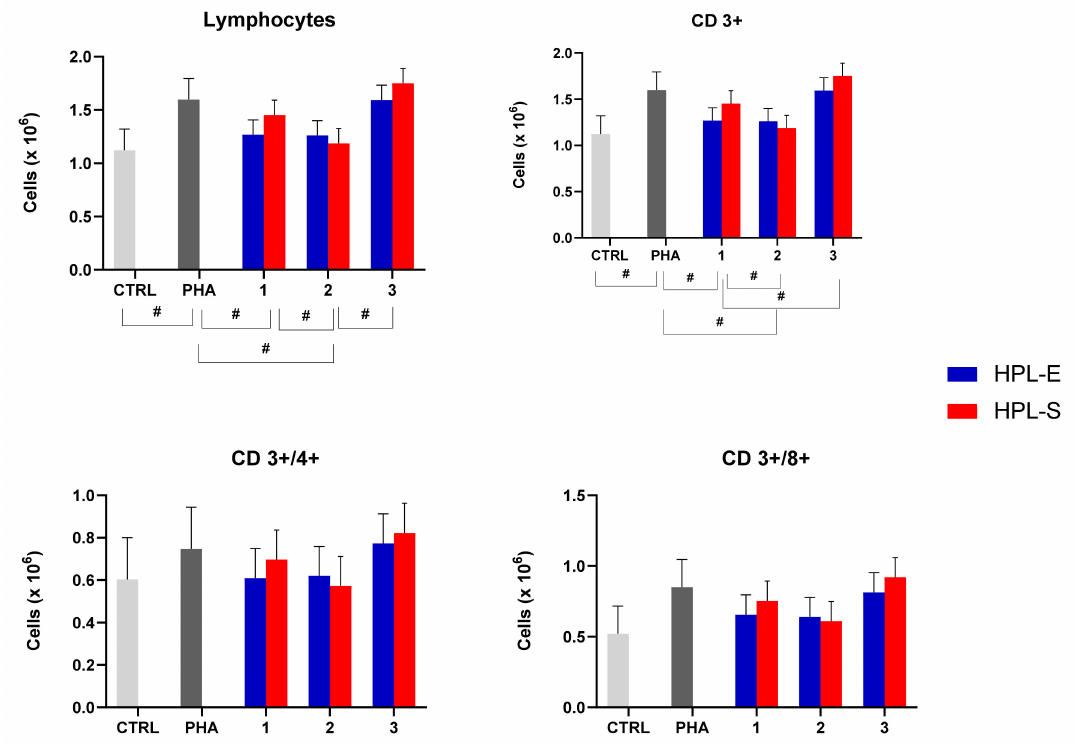
Figure 7. Analysis of the number of lymphocyte subpopulations from PHA-activated PBMCs after treatment with lyo-secretome from cell lines 1, 2, and 3 expanded with HPL-E or HPL-S. Multifactorial ANOVA, mean values ± LSD, n = 3 are illustrated. The symbol # indicate a significant difference between the means of the different batches (respectively, p < 0.05). No significant differences are reported between 2 HPLs in all analyzed